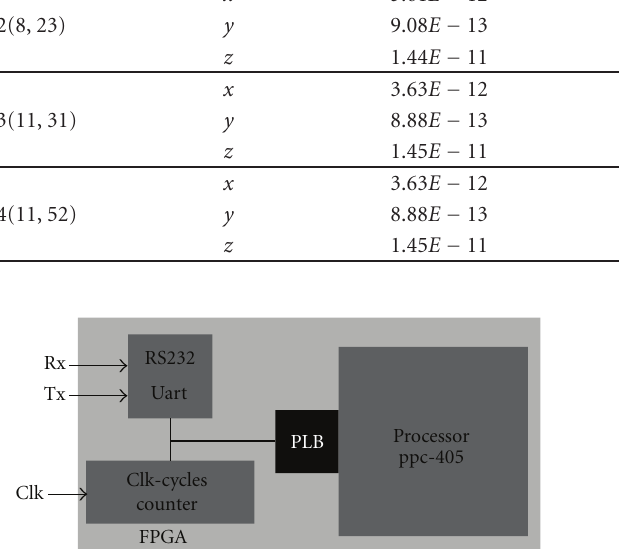
Figure 6: FPGA Architecture for Software Implementation.